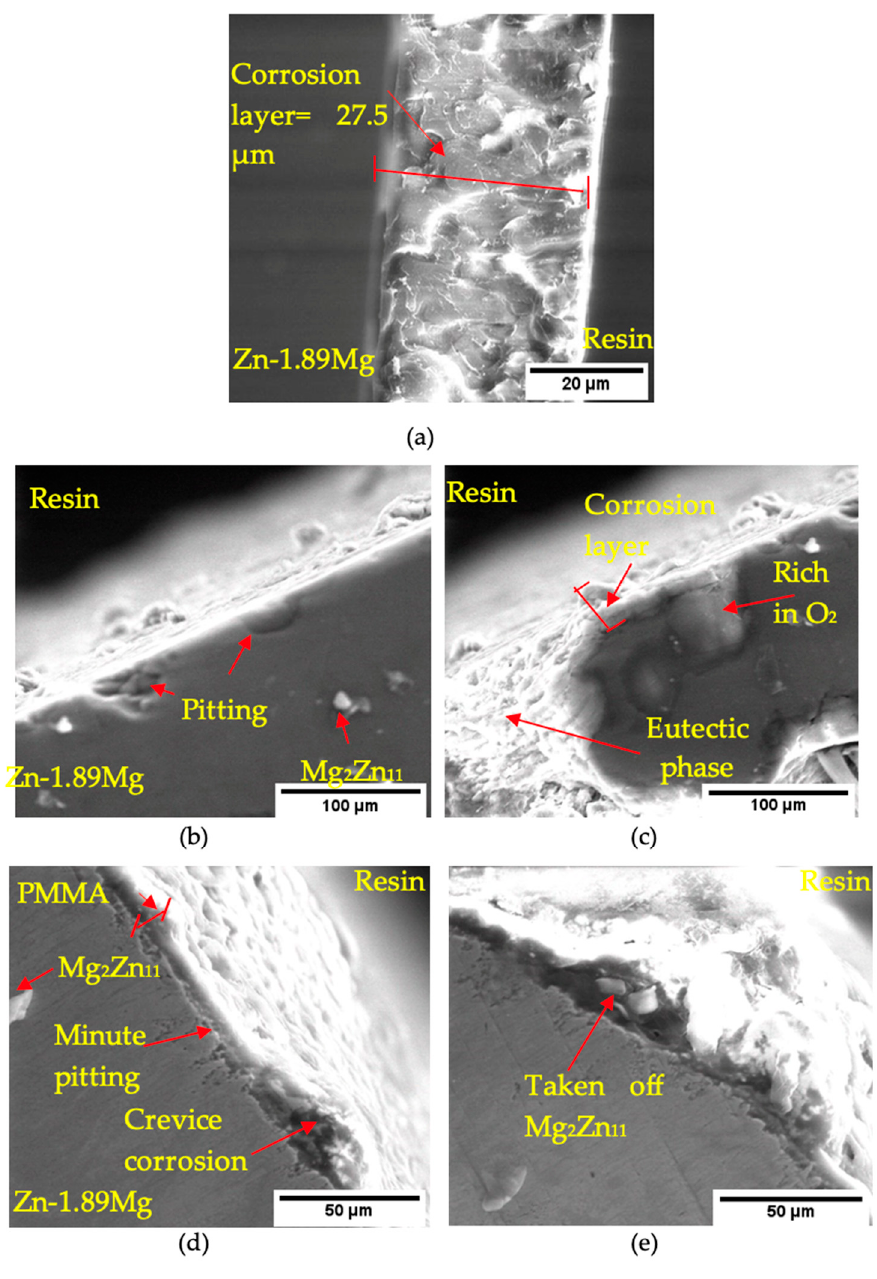
Figure 10. Cross-section (after 720 h of immersion in SBF) of: ( a ) pure Zn; ( b , c ) Zn-1.89Mg; ( d , e ) coated Zn-1.89M. Note the different scale bars for better representation of the features.